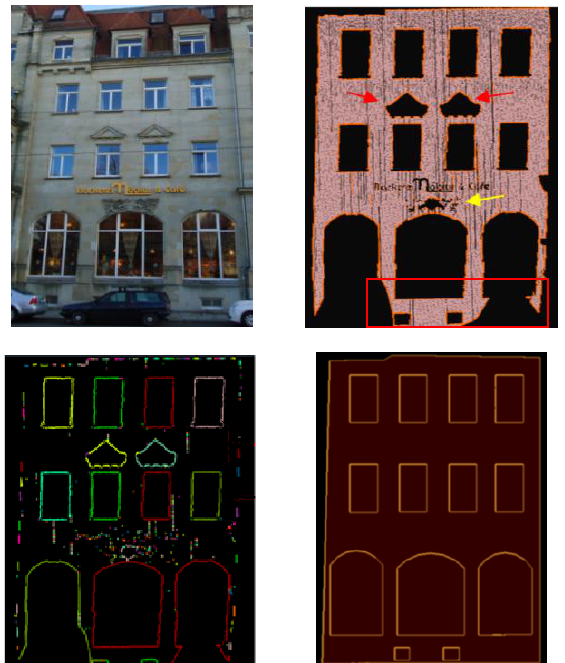
Figure 2: Results of façade reconstruction process for a selected wall: (a) a photograph; (b) detected edge points; (c) extracted clusters; and (d) final model